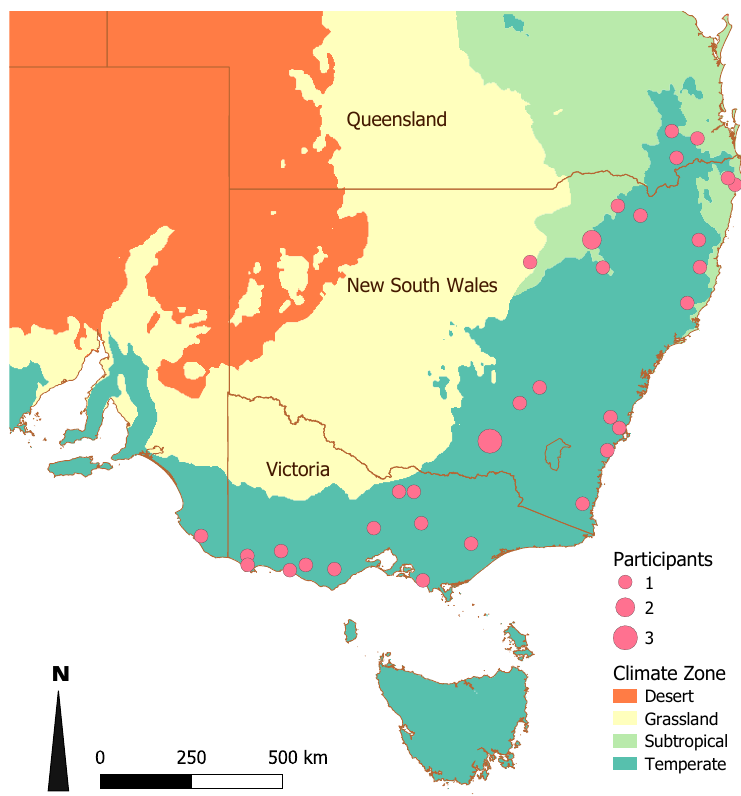
Figure 1. Location of participating veterinarians in a survey of veterinarians’ knowledge, attitudes and practices associated with bovine viral diarrhoea virus management on farms in the temperate zone of south-east Australia in 2019. Each dot is located on the centroid of the participant’s local government area (LGA); all LGSs extended into the temperate climate zone.